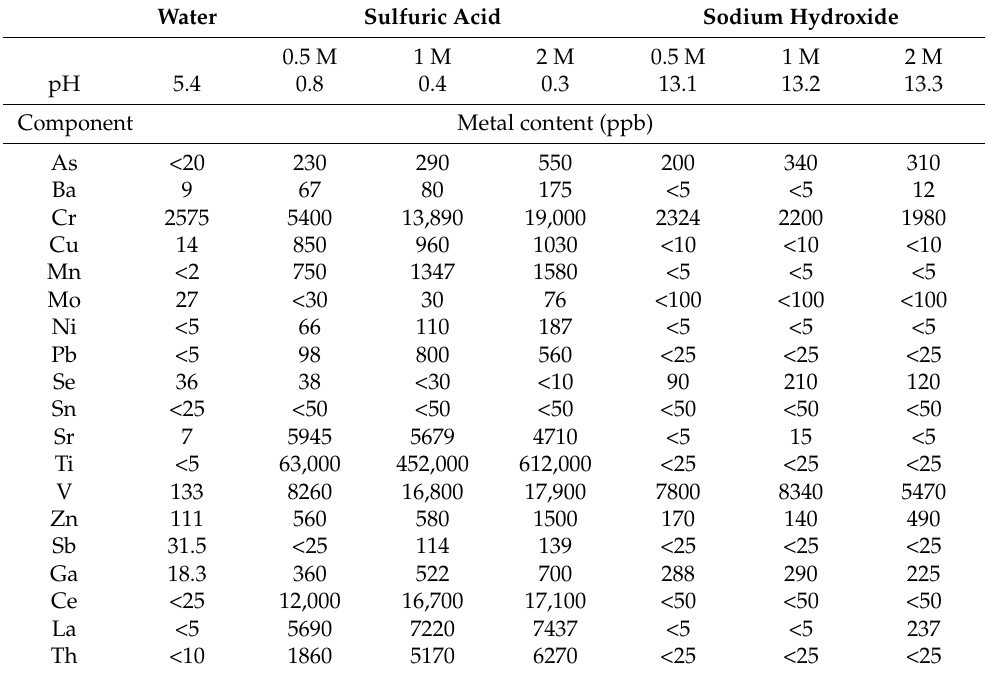
Table 4. Leachate composition in screening